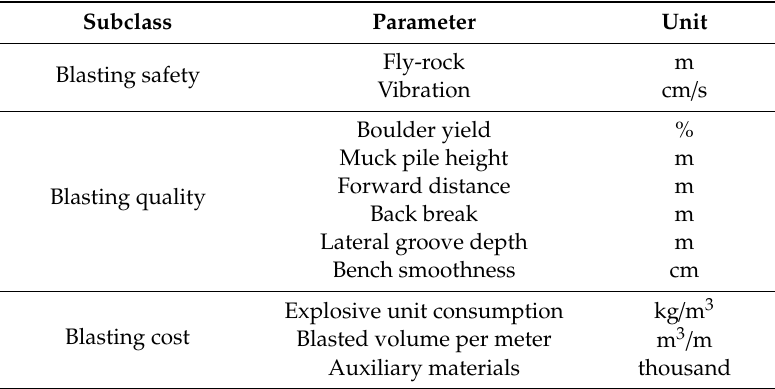
Table 1. Parameter